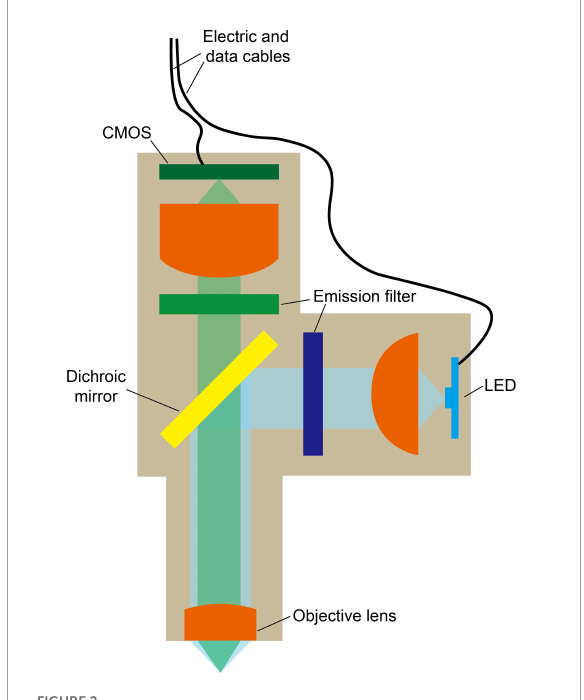
FIGURE2 Typical model of miniature single-photon fluorescence microscope. LED is used for wide-field excitation and fluorescence signal is recorded by a CMOS. Dichroic mirror is used to separate excitation light from emitted fluorescence. Cables are used for power and data